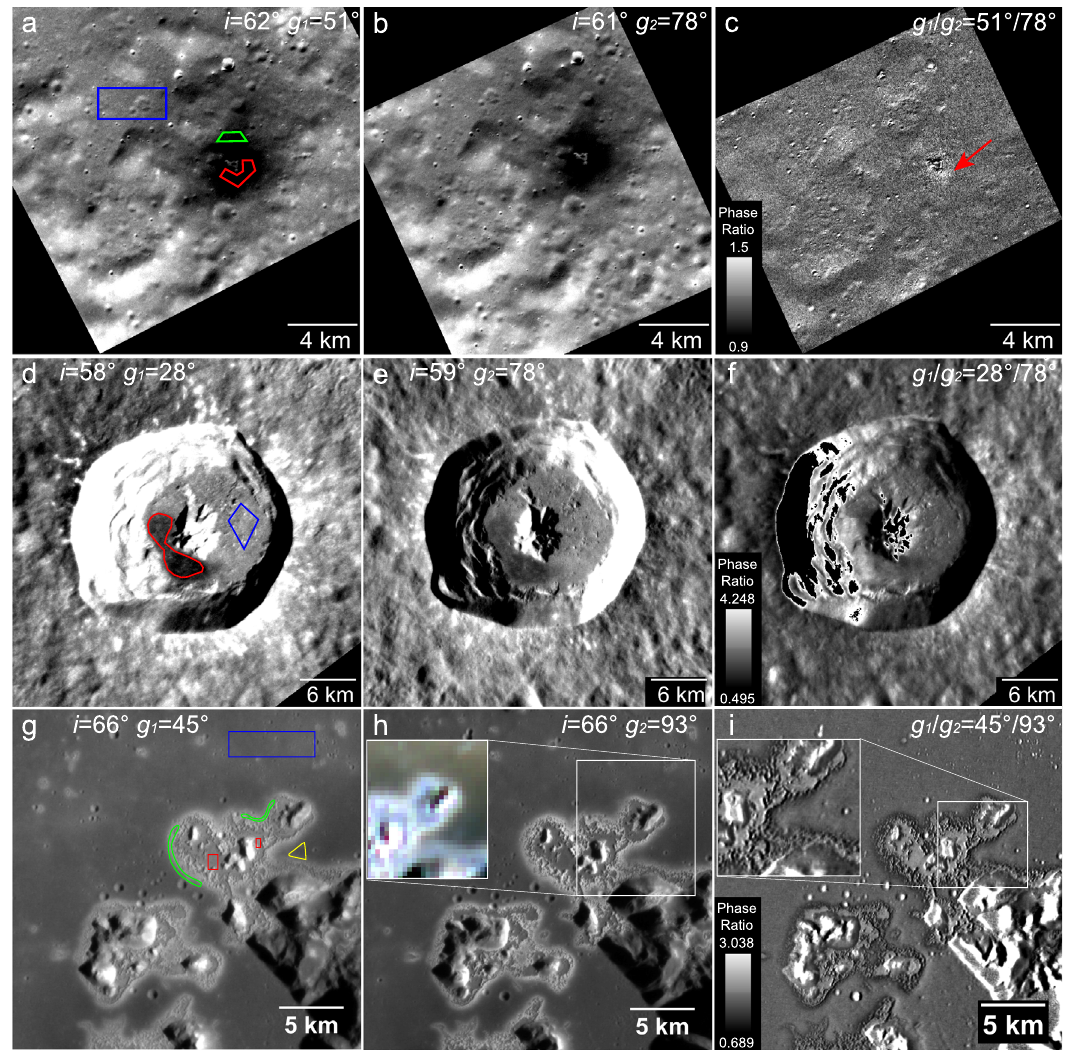
Fig. 3 Qualitative comparison of sub-pixel roughness between dark spot and regolith. For fl at areas shown in the ratio map, higher values correspond to greater roughness. Left column and middle column are base images with similar incidence angles ( i ) and different phase angles ( g ). Right column are phase-ratio maps in the form of R(g 1 ) / R(g 2 ) ( g 1 < g 2 ) for the two base images. Black regions represent areas without ratio values. a – c A dark spot located at 119.754 °E, 58.345 °N. Red and green polygons are the regions of interest (i.e., ROI) for the inner and outer dark spots, respectively. Blue polygon is the ROI of regolith. d – f A dark spot located in XiaoZhao crater (236.2 °E, 10.6 °N). Red and blue polygons are the ROI of dark spot and regolith, respectively. g – i Dark spots and hollows in Eminescu crater (114.3 °E, 10.7 °N). Red, green, yellow, and blue polygons are the ROIs of hollow fl oor, bright halos, dark spots, and regolith, respectively. Subpanel in h is a 3-band Wide Angle Camera (WAC) image, showing the location of dark spots. The subpanel in i shows a detail view for the phase-ratio behavior of dark spots, which exhibit whitish tones. Base images used in all the panels are listed in the Supplementary Table 2 and provided by